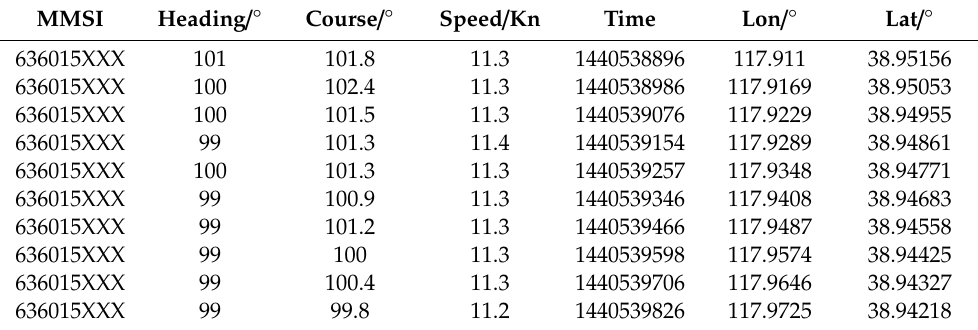
Table 2. AIS data structure storage. MMSI—maritime mobile service identity.